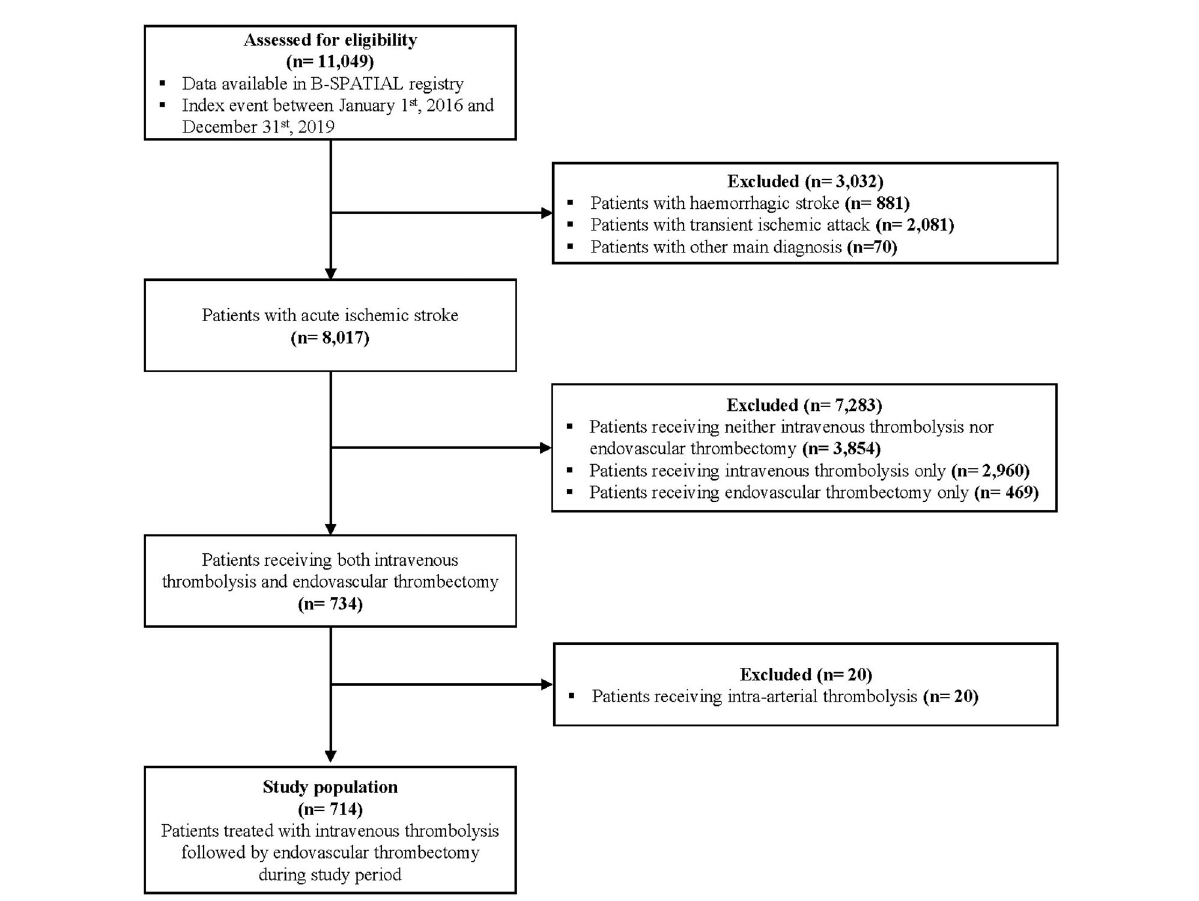
FIGURE1 Flow diagram of study eligibility. B-SPATIAL, Berlin-Specific Acute Treatment in ischemic and haemorrhagic Stroke with Long-Term